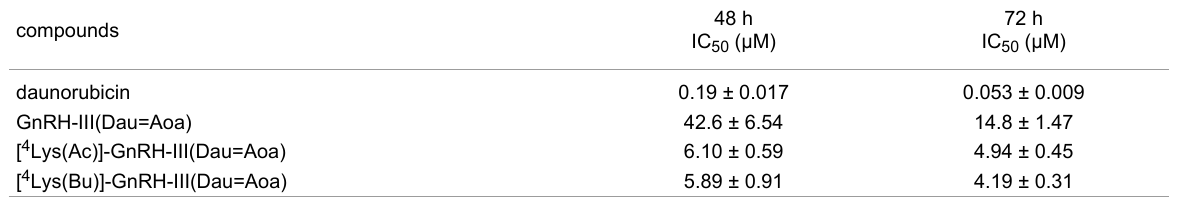
Table 2: Determination of the long-term cytotoxic effect of GnRH-III-based conjugates and daunorubicin (Dau). compounds